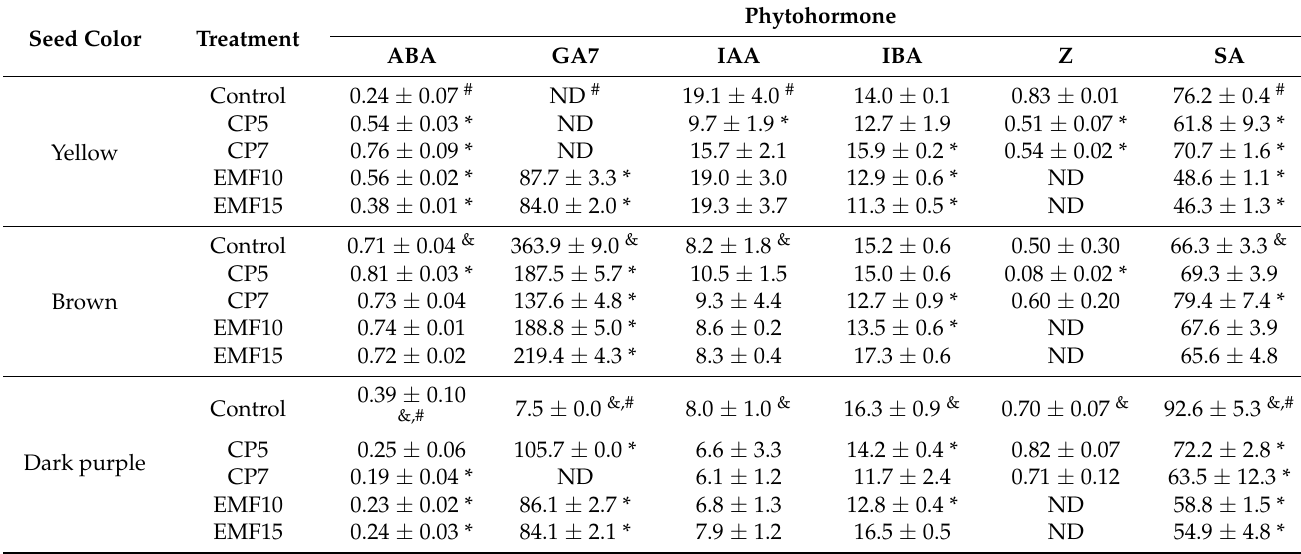
Table 2. Content of phytohormones ( µ g/g) in control and treated red clover seeds of different color. Seed Color Treatment